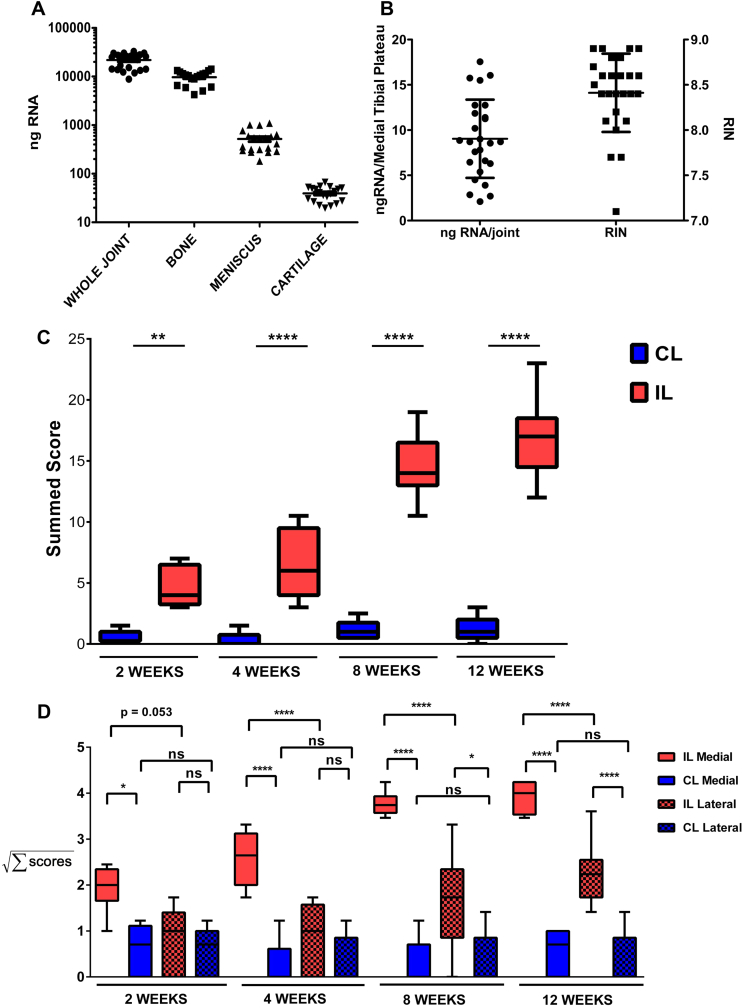
Quantity and quality of RNA isolated from dissected knee tissues and histological scores for cartilage degradation post-DMM. A: Amount of RNA isolated from a whole joint (n = 22; 11 animals, 10–14 weeks of age) and from cartilage (n = 20 each point is a pool of at least two joints; 30 mice in total, 10–14 years of age; the same group of 30 animals was used for the meniscus and bone RNA isolation), meniscus (n = 20) and tibial epiphysis with the cartilage removed (Bone) (n = 20). B: Amount per joint and quality of RNA isolated from MTP cartilage (n = 29; each point is a pool of 4–8 MTPs, we used 102 mice in total ranging from 10 to 18 weeks old. This group includes the 30 animals used on panel A and the 72 used for the microarray). C: Histological assessment of coronal knee sections at 2, 4, 8 and 12 weeks post-DMM. Boxes represent the summed histopathological score of cartilage degradation of the unoperated (CL, blue boxes) and operated knees (IL, red boxes). For each time point 10 mice were used (30 in total) (n = 10). The whiskers cover the breadth of the first to the ninety-ninth percentile of the scores with the median represented by the horizontal line in the box. The values for all groups approximate a Gaussian distribution (D'Agostino and Pearson omnibus normality test, P > 0.07). (*: P < 0.05, **: P < 0.01, ***: P < 0.001, ****: P < 0.0001 two way analysis of variance (ANOVA), Bonferroni post-hoc test, the P values are multiplicity adjusted). D: Histological assessment of coronal knee sections at 2, 4, 8 and 12 weeks post-DMM. Boxes represent the summed histopathological score of cartilage degradation of the unoperated (CL, blue boxes) and operated knees (IL, red boxes) on the medial (solid boxes) and lateral (checked boxes) side. For each time point 10 mice were used (30 in total) (n = 10). The whiskers cover the breadth of the first to the ninety-ninth percentile of the scores with the median represented by the horizontal line in the box. The data were transformed by taking the square root of the values prior to the statistical testing. After transformation the values for all groups approximate a Gaussian distribution (D'Agostino and Pearson omnibus normality test, P > 0.07. (*: P < 0.05, **: P < 0.01, ***: P < 0.001, ****: P < 0.0001 two way ANOVA, Bonferroni post-hoc test, the P values are multiplicity adjusted).